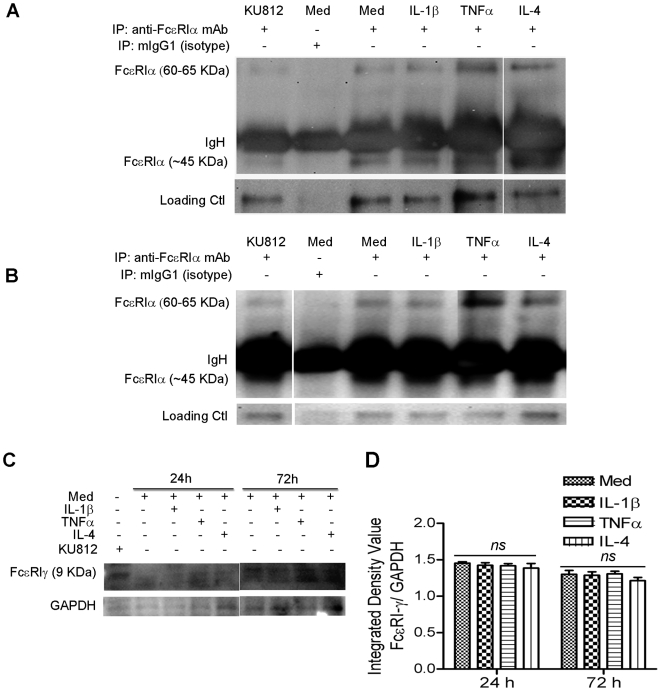
FcεRI-α protein expression (24, 72 h) is upregulated by proinflammatory and Th-2 cytokines.Two-day serum-deprived primary B/TSM cells were cultured in presence or absence of IL-1β, TNF-α or IL-4. FcεRI-α protein from (A) 24 h and (B) 72 h culture cell lysates was Immunoprecipitated (IP) followed by Western blotting, as described in
Materials and Methods
 section. FcεRI-α protein was immunoprecipitated with either anti-FcεRIα mAb 15/1 or with isotype antibody mouse IgG1 (MOPC21) for negative control. Non-specific bands from the same gels were used as loading control. (C) FcεRI-γ protein was analyzed by Western blotting and (D) presented as the ratio of 9 KDa FcεRI-γ-specific protein bands intensity over GAPDH (as internal control). Human basophilic KU812 cells were used as a positive control. Figures represent three separate experiments. ns, non-significant (p>0.05).